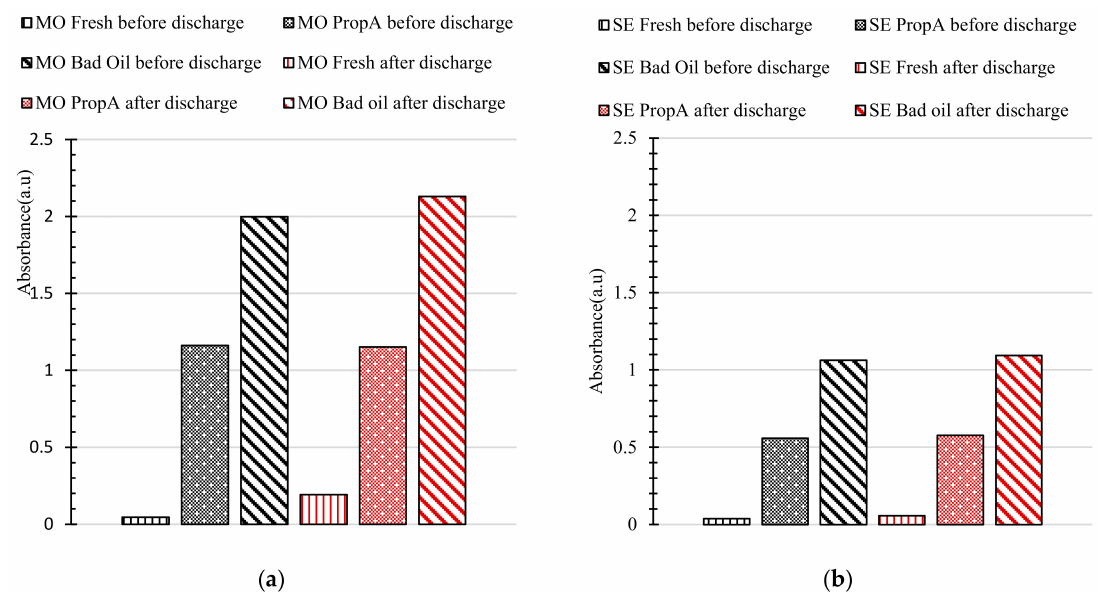
Figure 3. Change in absorbance at di ff erent aging conditions for before and after discharge: ( a ) for mineral oil; ( b ) for synthetic esters.